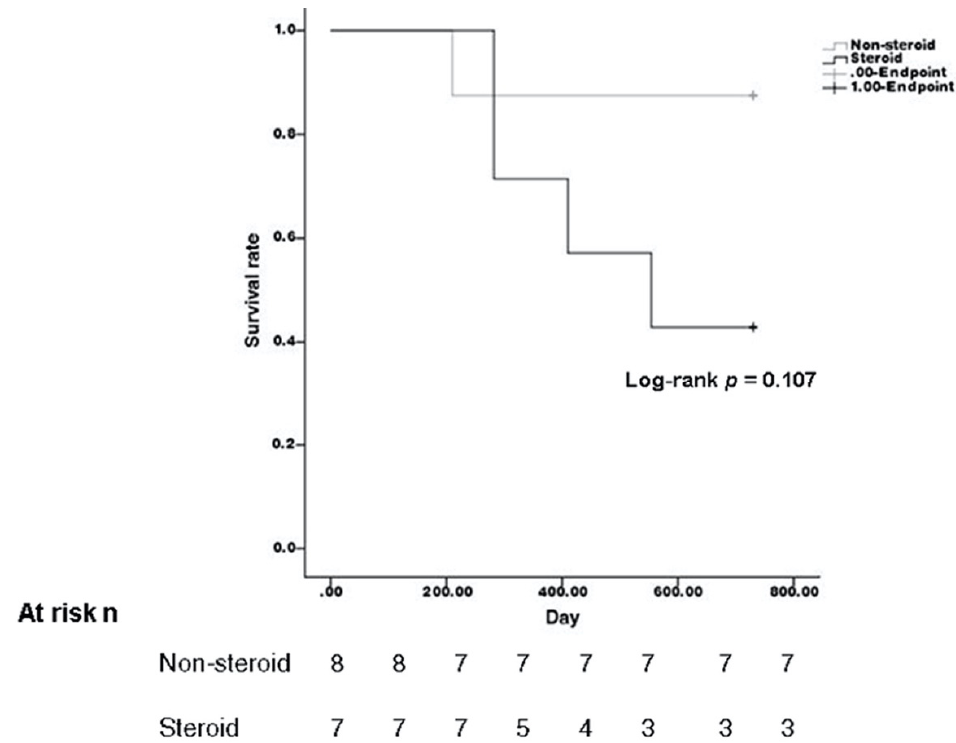
Figure 3. Kaplan-Meier Method comparing the recurrence rate of steroid and non-steroid group.